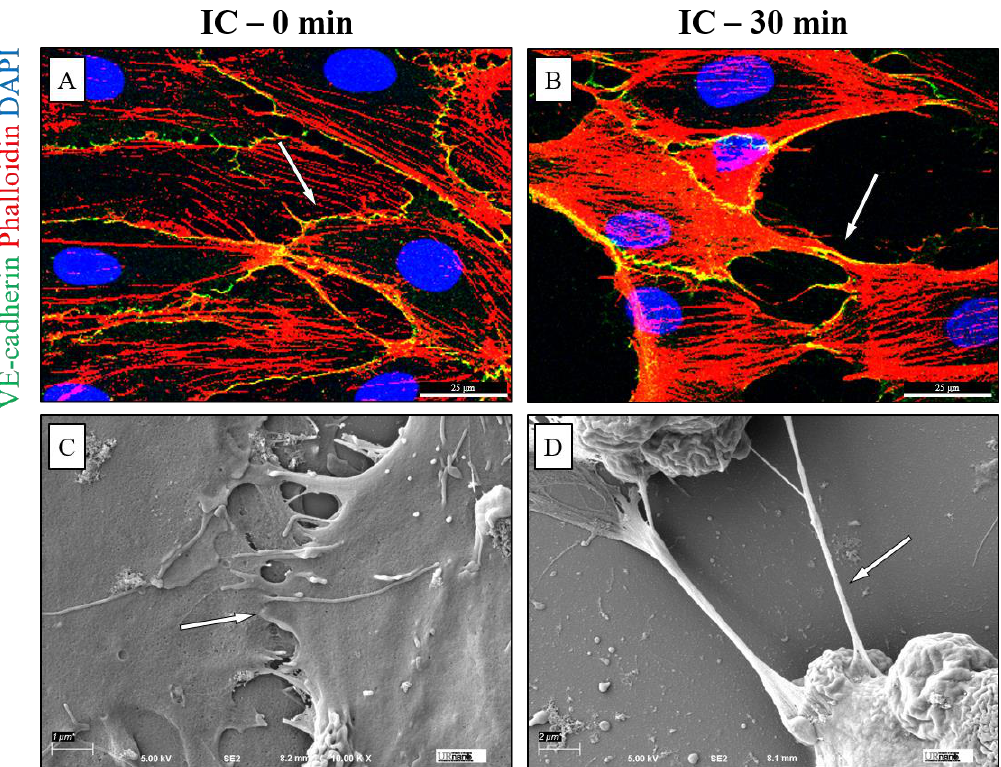
Figure 5. IC-induced loss of intercellular interaction visualized with confocal microscopy and SEM. Type O HPAEC were treated with ( A , C ) media alone or ( B , D ) concentrated plasma-derived IC 1:1 with media for 30 min. ( A , B ) Cells were stained with anti-VE-Cadherin (green) to visualize AJs, Phalloidin-594 (red) to mark actin stress fibers, and DAPI (blue) to stain nuclei and imaged at 40 × and presented as merged images. Yellow color indicates regions of red and green colocalization. ( C , D ) Cell surface imaging was performed by SEM and viewed at 10,000 × (control) or 5000 × (IC). Arrows denote regions of cell surface contact between adjacent